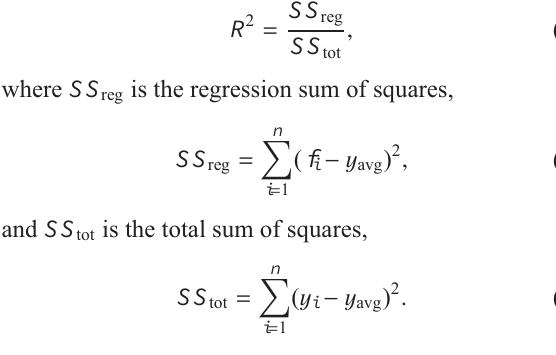
where K = 1 × 10 − 16 in unit [ sKm − 1 ] and x = v p r p